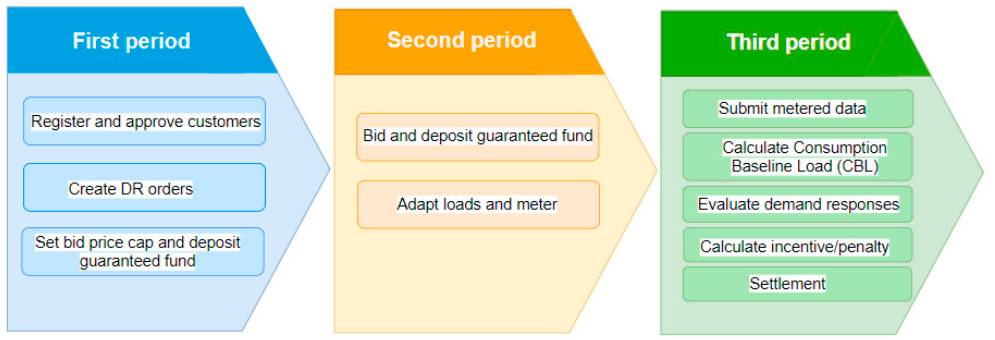
Figure 3. The demand response bidding mechanism.